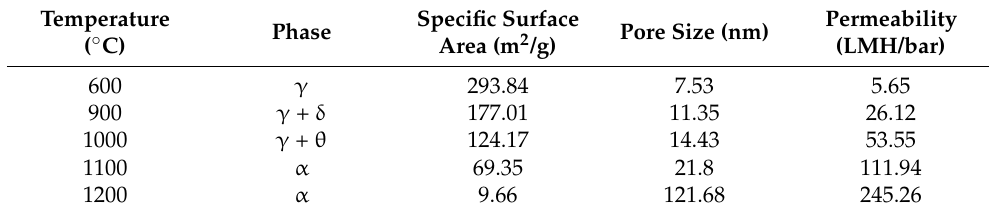
Table 1. Effect of the different sintering temperatures on the properties of the alumina membranes.